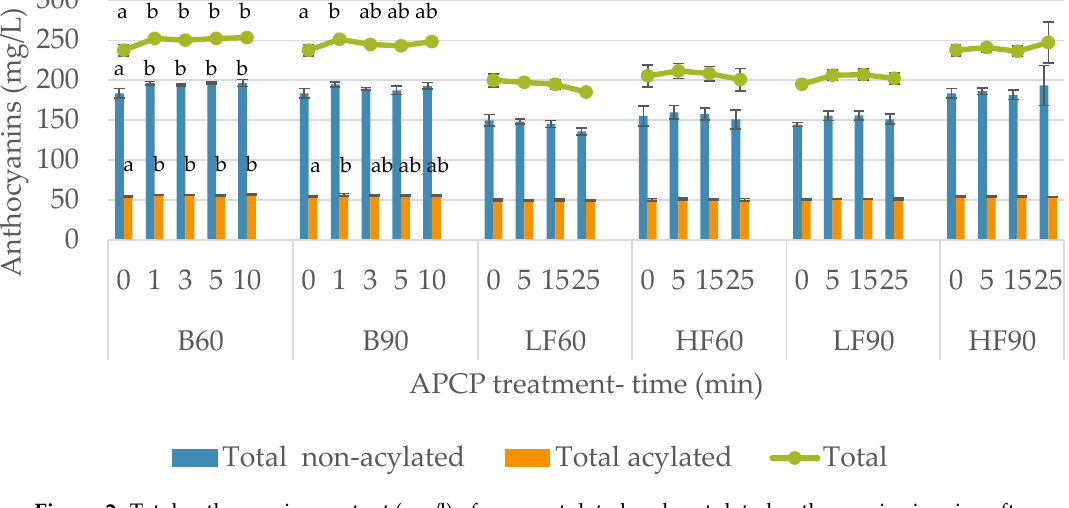
Figure 2. Total anthocyanins content (mg/l) of non-acetylated and acetylated anthocyanins in wine after different Argon-APCP treatments applied different times (0, 5, 15, and 25 min). Error bars represent the standard deviation ( n = 3). Different letters mean significant differences between samples ( p ≤ 0.01). No letters mean no significant differences.